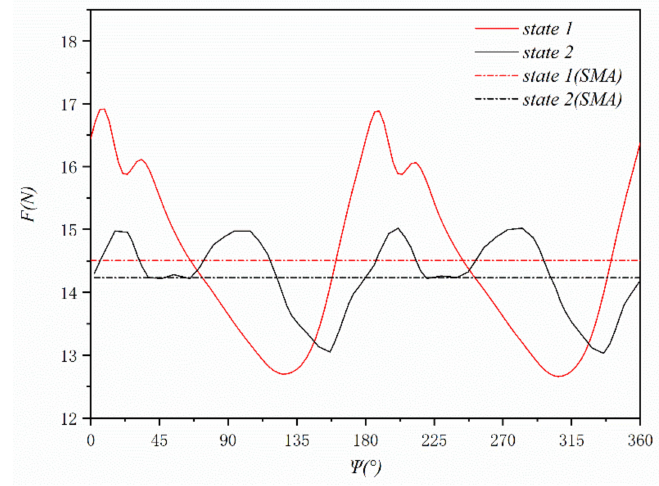
Figure 23. The lift on the flat tail in hover.